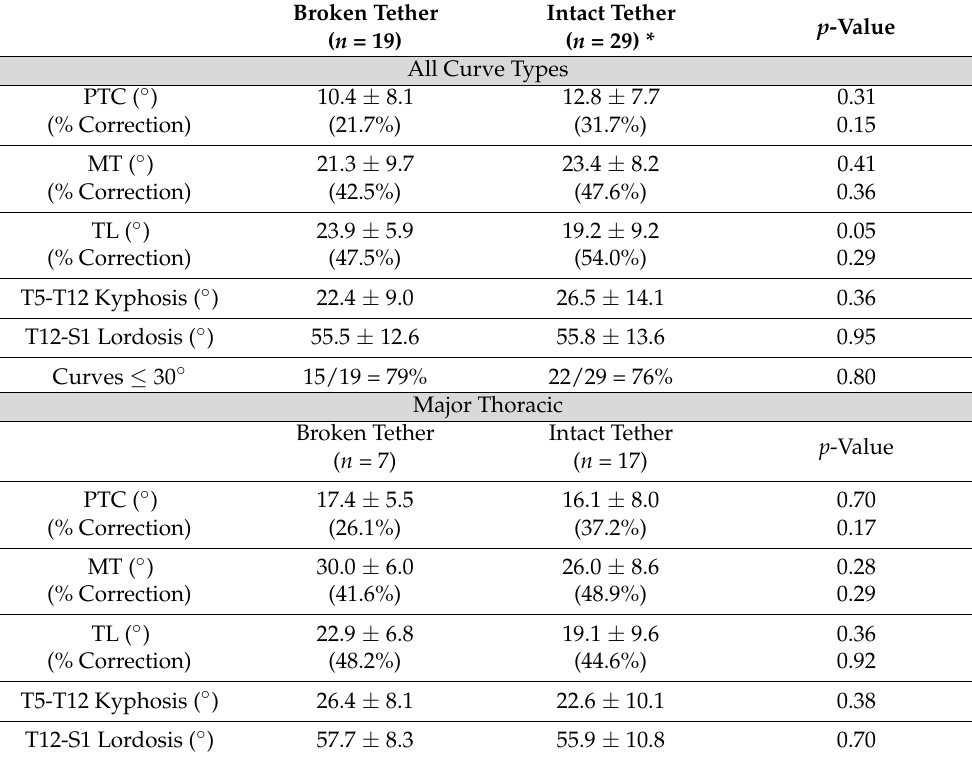
Table 4. Comparison of patients with broken and intact tethers at latest follow-up.